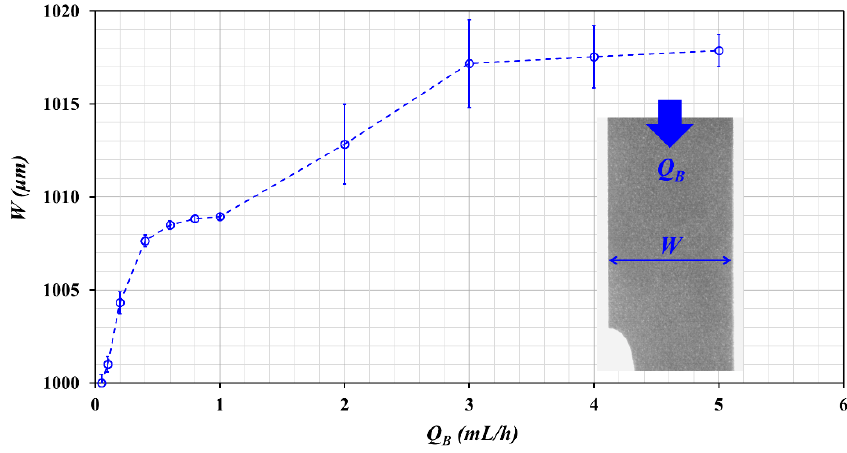
Figure A2. Variations of channel width under blood flow rate ( Q B ).